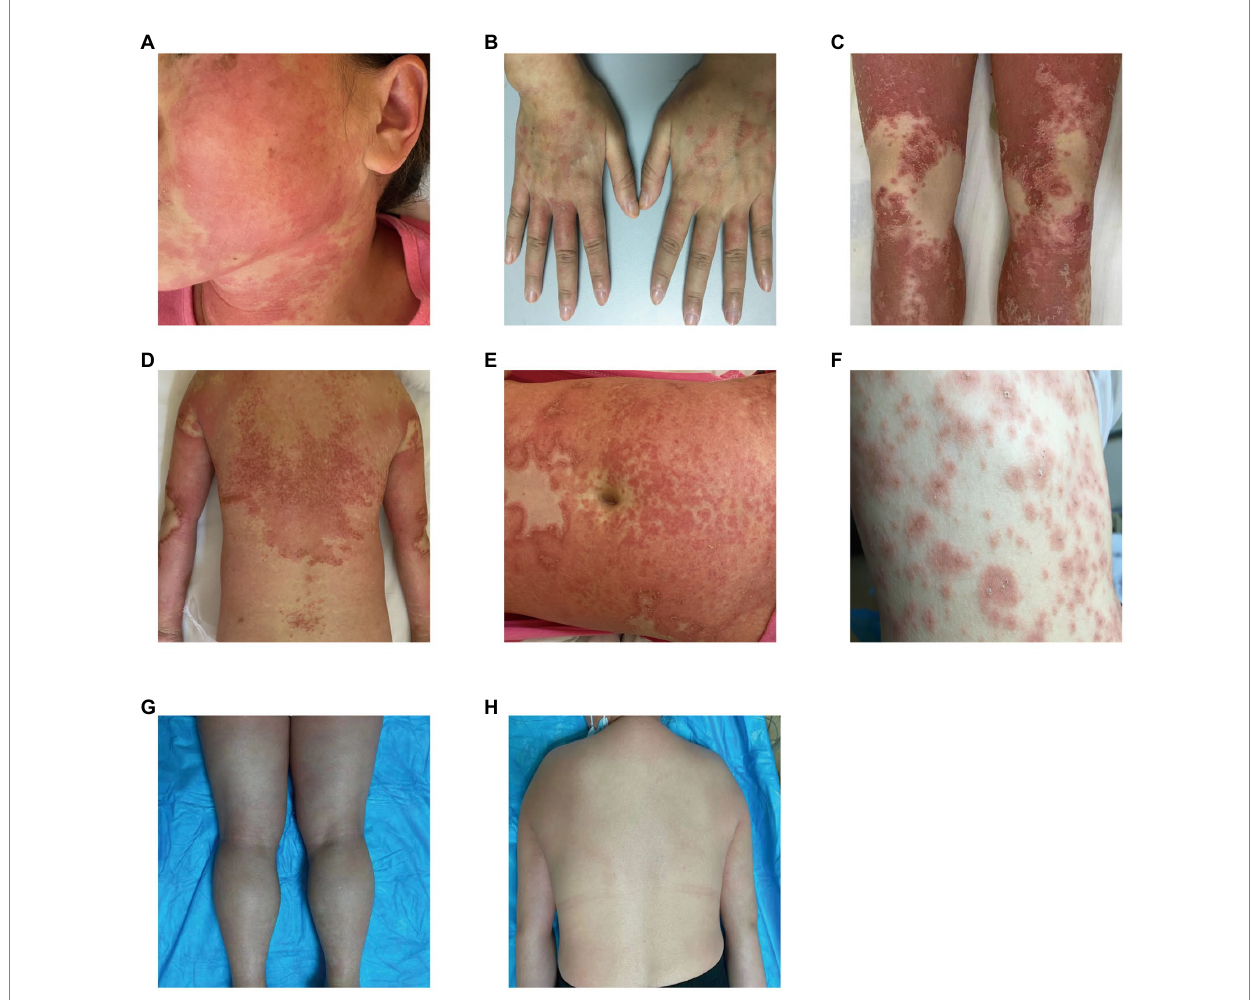
FIGURE 1 Rash before and after treatment. (A) Rash on the face; (B) rash on the hands; (C) rash on the legs; (D) rash on the back; (E) rash on the abdomen; (F) rash on the chest; (G) improvement in the rash on the legs; and (H) improvement in the rash on the